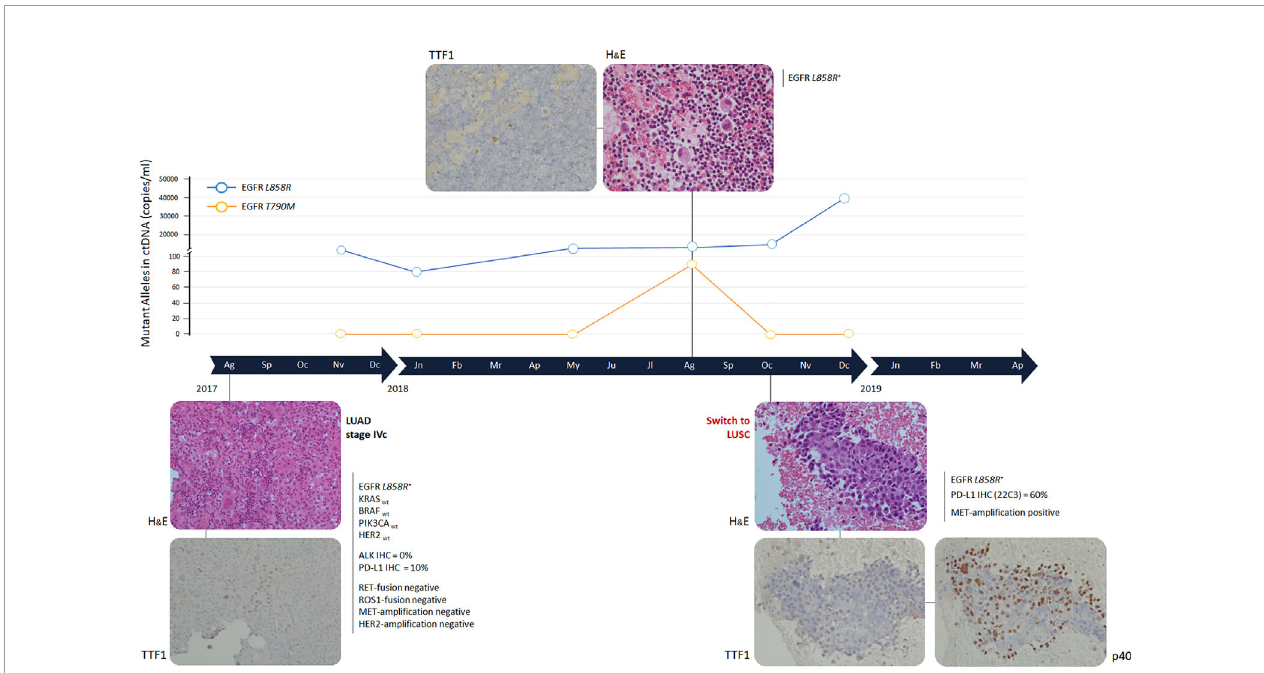
FIGURE 1 | Timeline and histological transformation. H&E: Hematossil and Eosin staining (magni fi cation 20X). Immunohistochemistry analyses were performed using mouse monoclonal antibodies anti TTF-1 and p40, clone 8G7G3/1 and clone BC28 respectively, on the Ventana Medical System (Roche). Immonuhistochemistry images have been reported with a 20X magni fi cation. Gene mutational analysis was performed by Sequenom MassArray at baseline, EGFR mutational status was determined by digital droplet PCR at progression times. ALK and PD-L1 were evaluated by immunohistochemistry and gene fusions and ampli fi cations by fl uorescent in situ hybridization. LUAD, lung adenocarcinoma; LUSC, lung squamous-cell